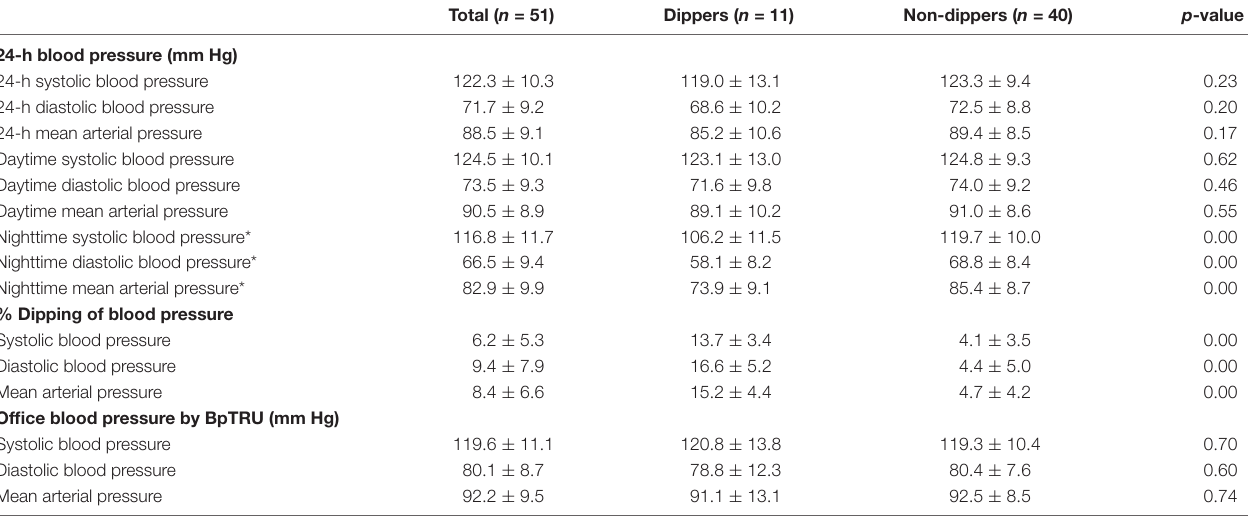
TABLE 3 | 24-h blood pressure and % blood pressure dipping of participants stratified by blood pressure dipping status. Total ( n = 51) Dippers ( n = 11) Non-dippers ( n =